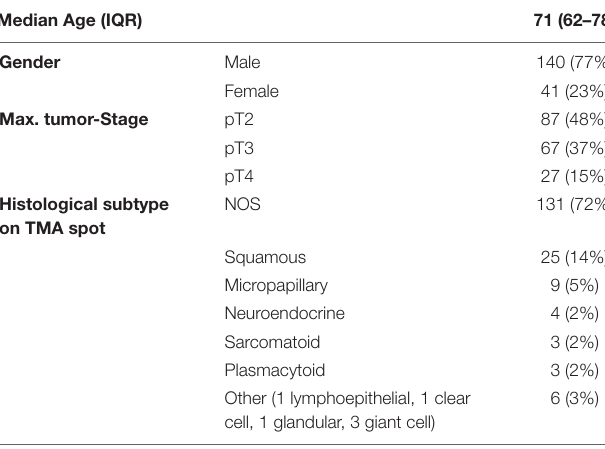
TABLE 1 | Clinico-pathological details of 181 patients on the TMA analyzed for histological subtype of urothelial carcinoma and